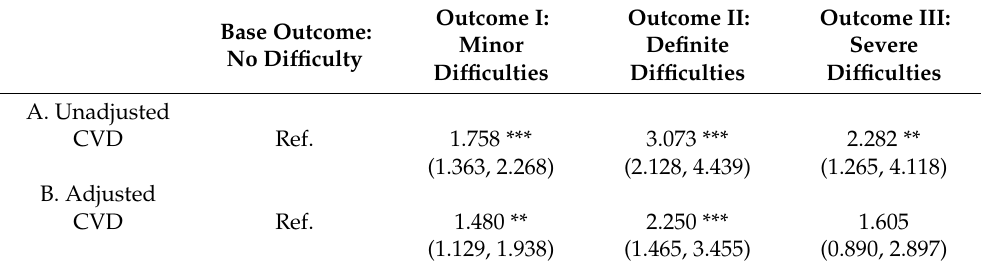
Table 5. Relative risk ratios in favor of difficulties in emotions, concentration, behavior, or being able to get along with other